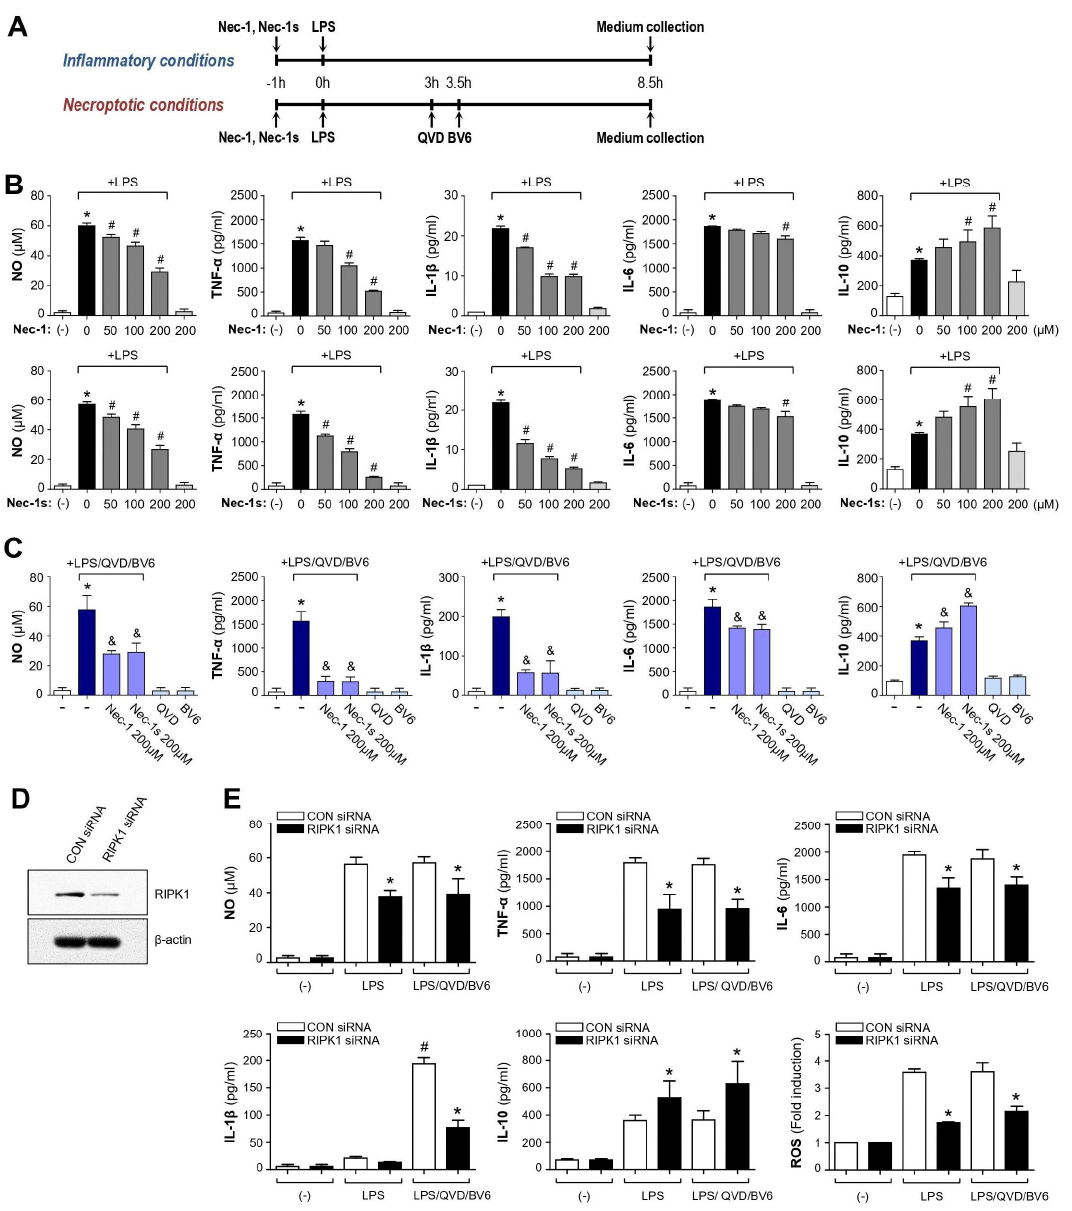
Figure 1. Effect of Nec-1, Nec-1s, and RIPK1 siRNA on NO and inflammatory molecules in LPS or LPS/QVD/BV6-stimulated BV2 microglial cells. ( A ) Scheme of the experimental procedure. ( B ) BV2 cells were pretreated with Nec-1 or Nec-1s for 1 h and incubated with LPS (100 ng/mL). After incubation for 8.5 h, the supernatants were obtained, and the levels of NO, TNF- α , IL-1 β , IL-6, and IL-10 were measured. ( C ) BV2 cells were pretreated with Nec-1 and Nec-1s for 1 h and preincubated with or without LPS for 3 h and were then pretreated with QVD (10 µ M) for 30 min before stimulation with BV6 (5 µ M) for 5 h. The levels of NO and cytokines released into media were measured. All data are shown as the mean value ± SEM of three independent experiments. * p < 0.05 vs. control; # p < 0.05 vs. LPS-treated samples; & p < 0.05 vs. LPS/QVD/BV6-treated samples. ( D ) Downregulation of RIPK1 expression by RIPK1 siRNA was confirmed by Western blot analysis. ( E ) The cells transfected with RIPK1 siRNA or control siRNA were treated with LPS or LPS/QVD/BV6 for 8.5 h. Then, the amounts of cytokines released into the media and intracellular ROS levels were determined. All data are shown as the mean value ± SEM of three independent experiments. # p < 0.05 vs. CON siRNA-transfected cells in the presence of LPS, * p < 0.05 vs. CON siRNA-transfected cells in the presence of LPS or